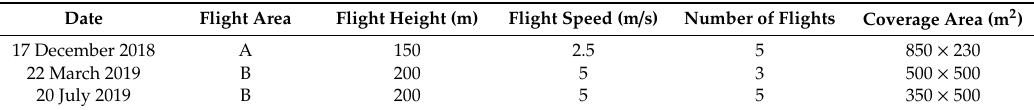
Table 1. Flight parameters of the unmanned aerial vehicle (UAV).